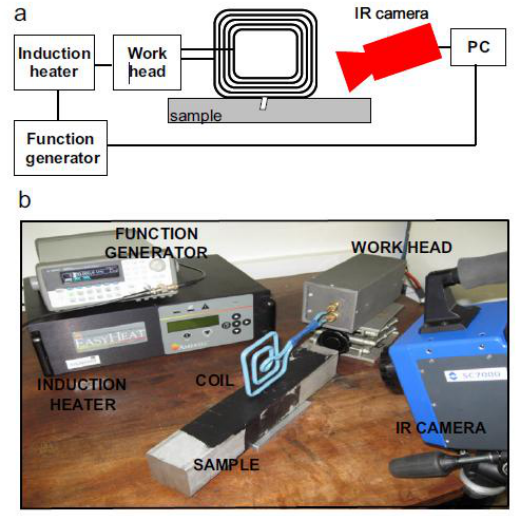
Figure 17. Experimental set-up of pulsed eddy current stimulated thermography, with permission Figure 17. System set-up diagram ( a ) and experimental set-up ( b ) of pulsed ECST, with permission from 125. from